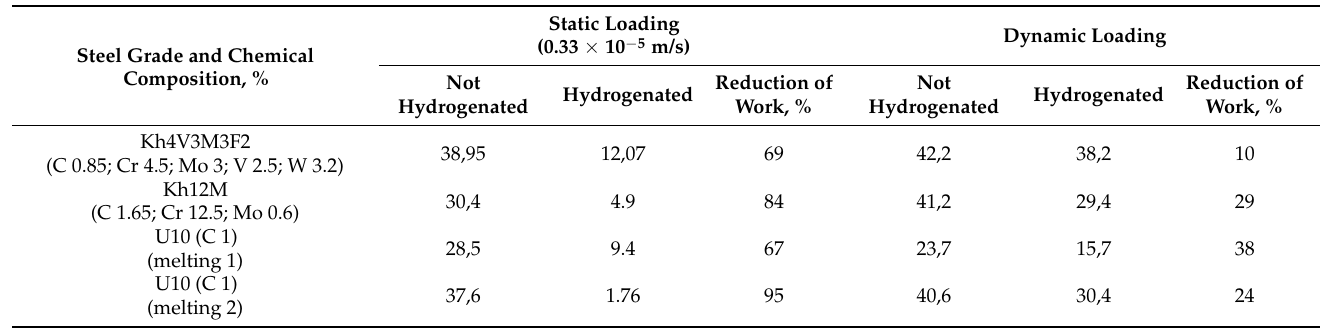
Table 6. Change in the work of destruction (J) of steel smooth samples under the influence of “internal” hydrogen at static and dynamic bending [26].